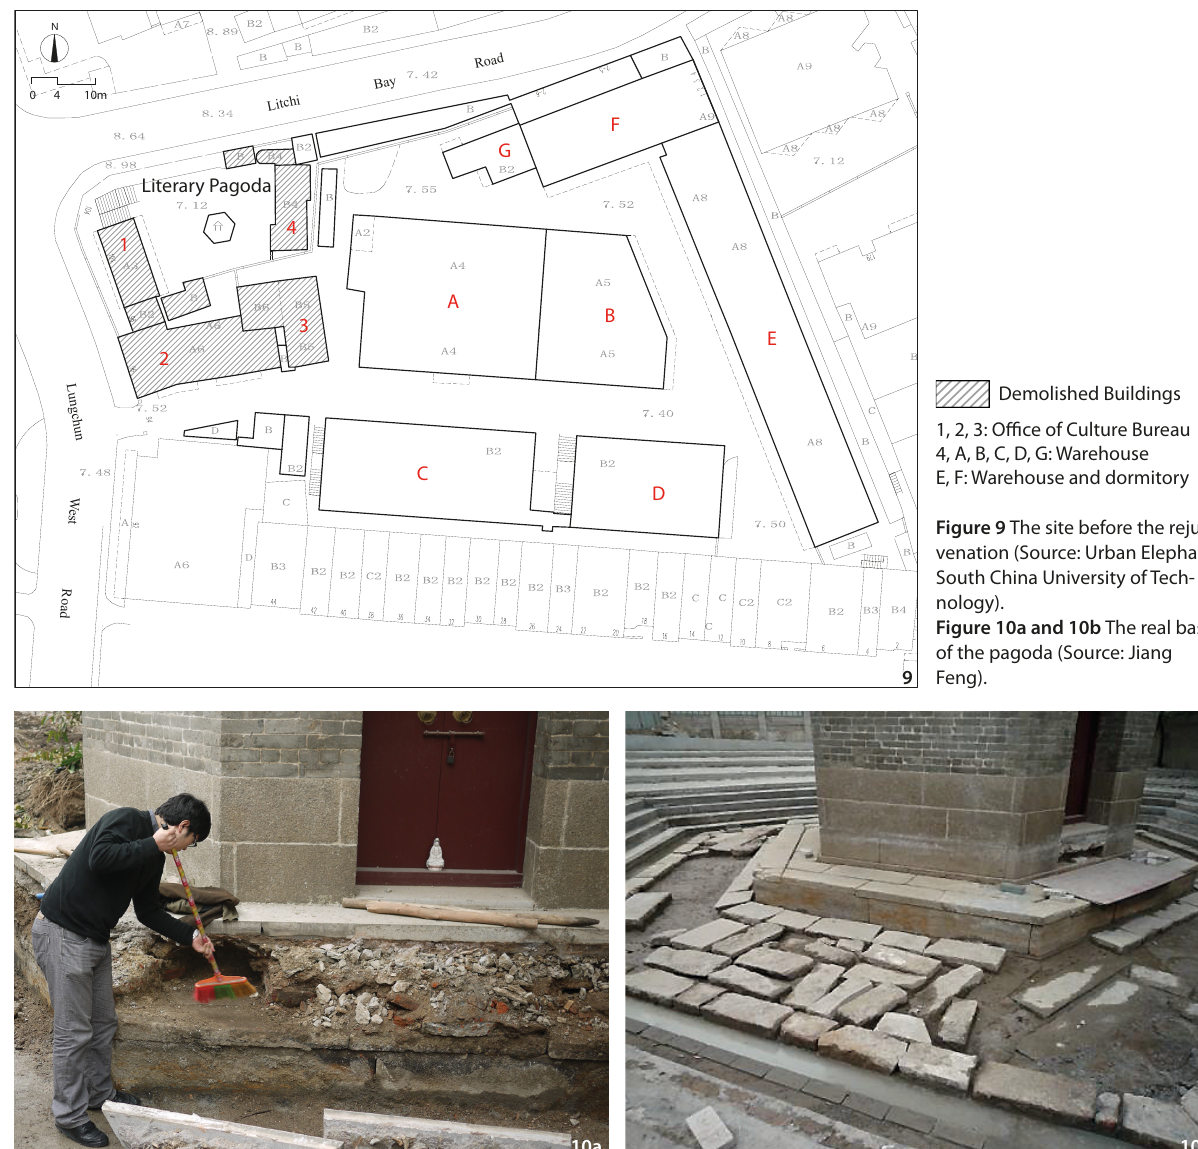
Figure 9 The site before the reju- venation (Source: Urban Elephant, South China University of Tech- nology). Figure 10a and 10b The real base of the pagoda (Source: Jiang Feng).